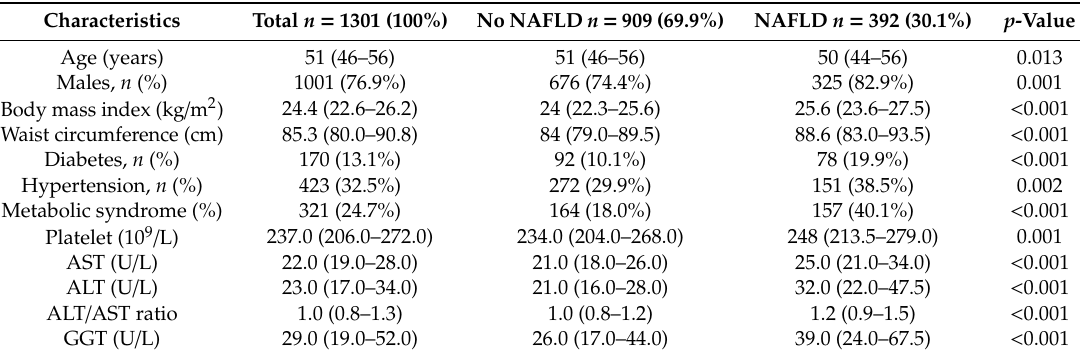
Table 1. Baseline characteristics of the study